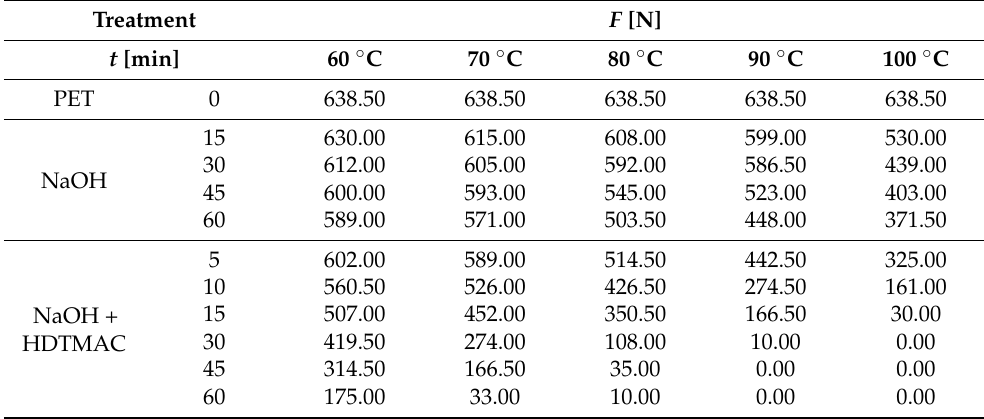
Table 1. Breaking force ( F ) of PET fabrics before and after hydrolysis at 60 to 100 ◦ C.